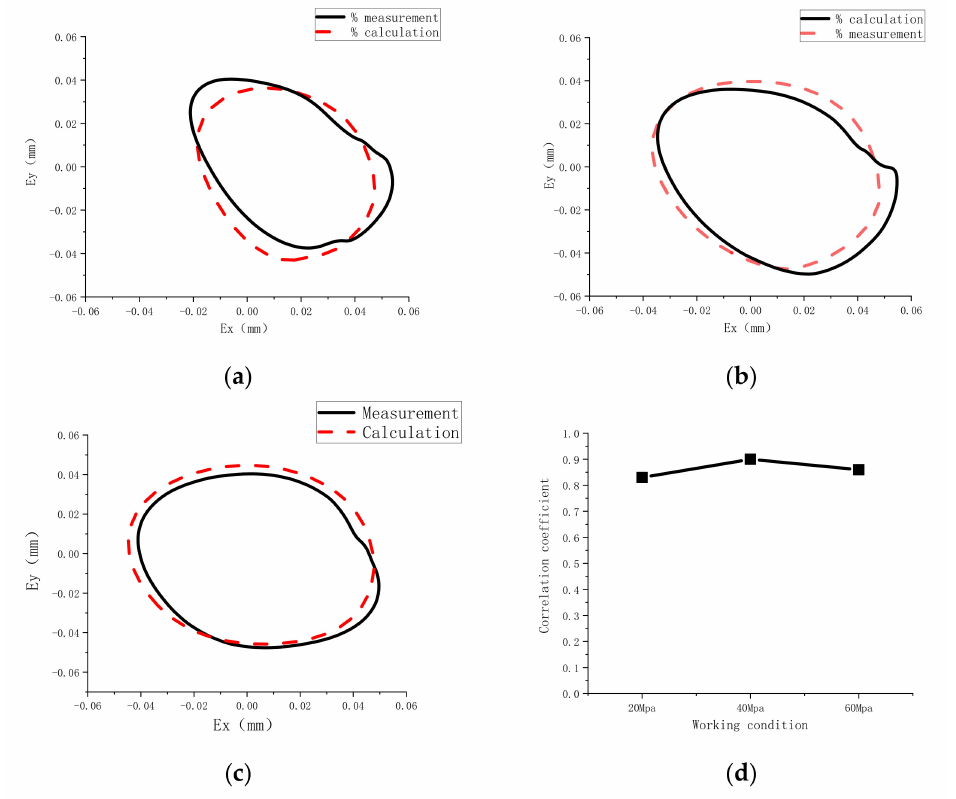
Figure 5. Axis orbits of tests and simulation calculations at di ff erent loads: ( a ) Test and calculation results at 20 MPa; ( b ) Test and calculation results at 40 MPa; ( c ) Test and calculation results at 60 MPa; ( d ) Comparison of calculation and test results under di ff erent